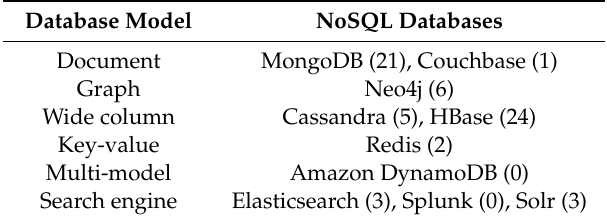
Table 2. Mainstream NoSQL databases and the number of related articles found within